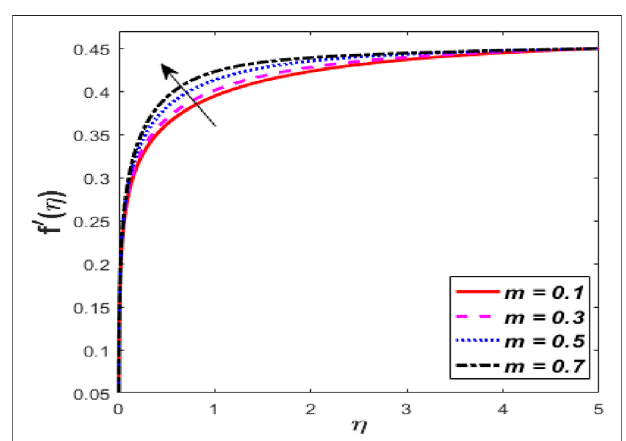
FIGURE 4 | m against f ′ ( η )